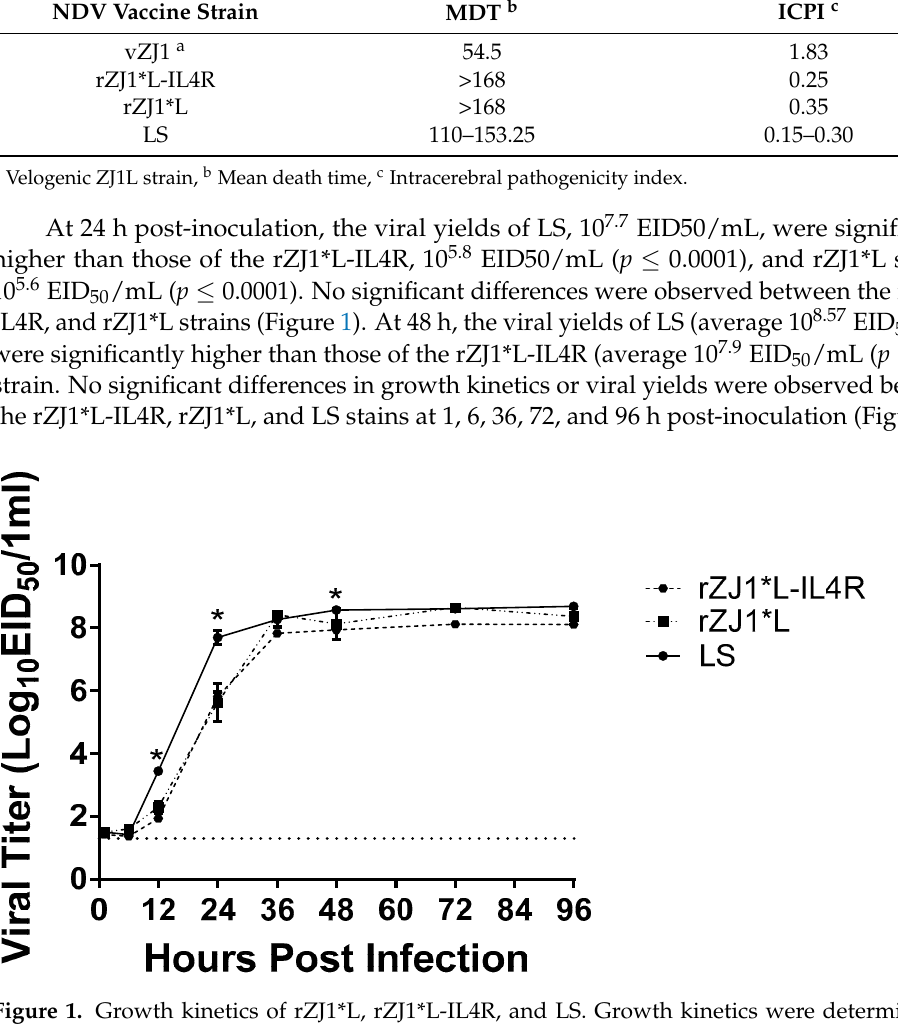
Table 1. Mean death time (MDT) and intracerebral pathogenicity index (ICPI) of lentogenic NDV vaccine strains and vNDV challenge strain.